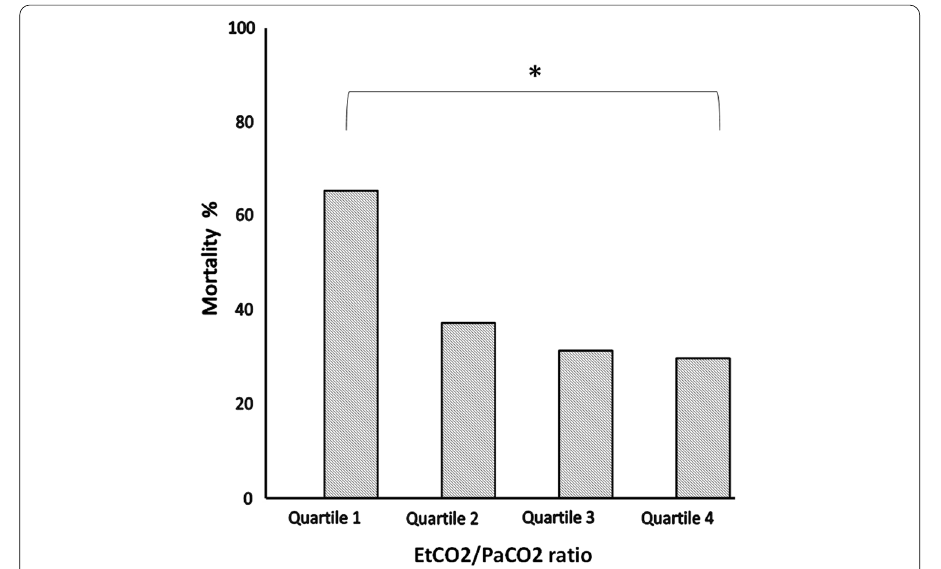
Fig. 2 Mortality rate observed in the four quartiles of P ET CO 2 /PaCO 2 ratio